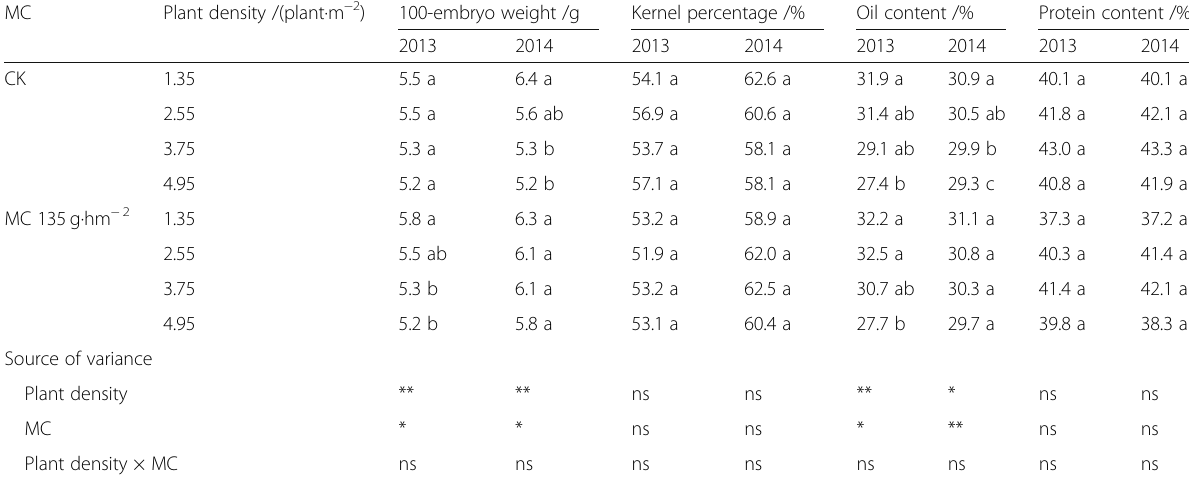
Table 3 Effects of mepiquat chloride (MC) on cottonseed oil content and protein content under different plant densities in Sikang 1